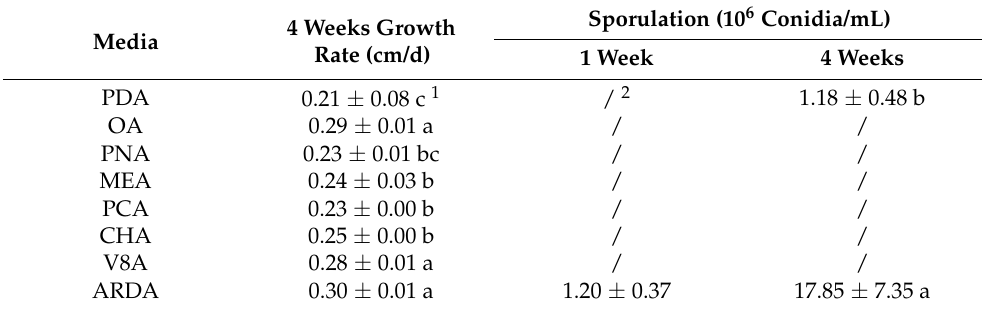
Table 2. Mean ( ± SEM) growth rates and sporulation of Paraphoma radicina on eight different media grown at L:D 0:24 h and 25 ◦ C and measured one and four weeks after